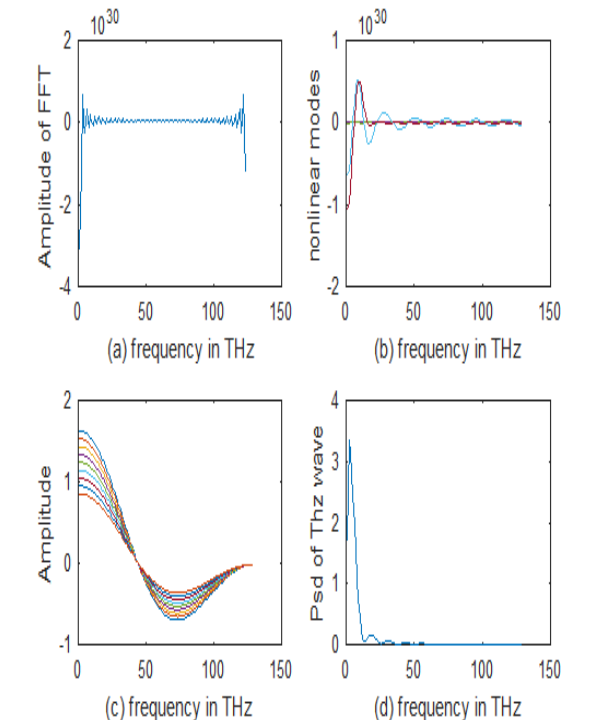
Figure 8: Outputs of a nonlinear wave obtained by a Kerr nonlinear material showing (a) Super continuum effect (b) modes in a nonlinear waveguide (c) Spectrum of waves in time frequency domain (d) Psd of a THz wave